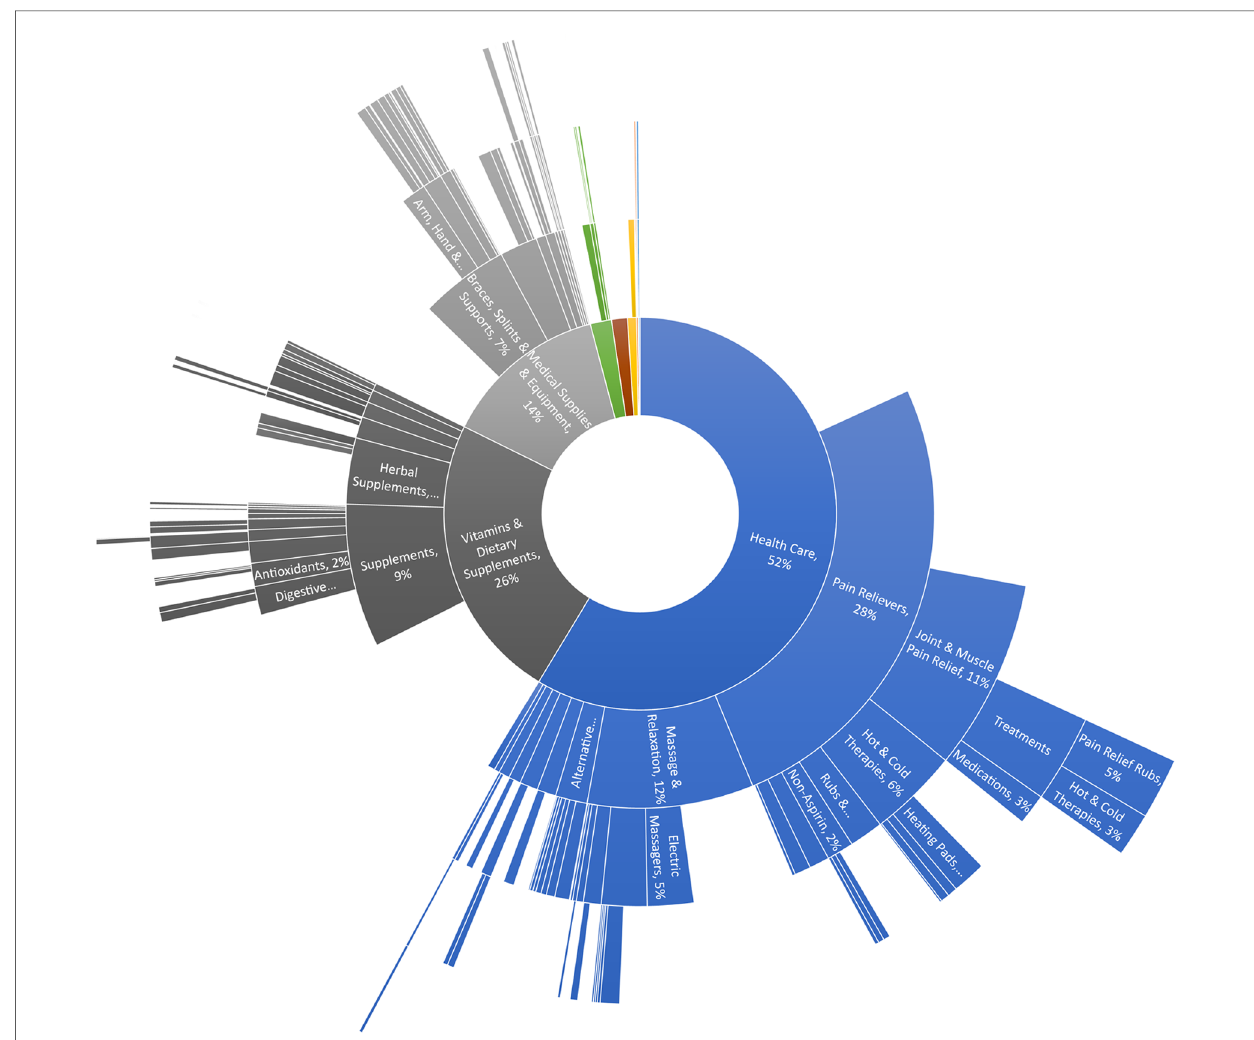
FIGURE 3 Sunburst chart of the product categories. These are based on 1,098 distinct products, with at least one review text mentioning chronic